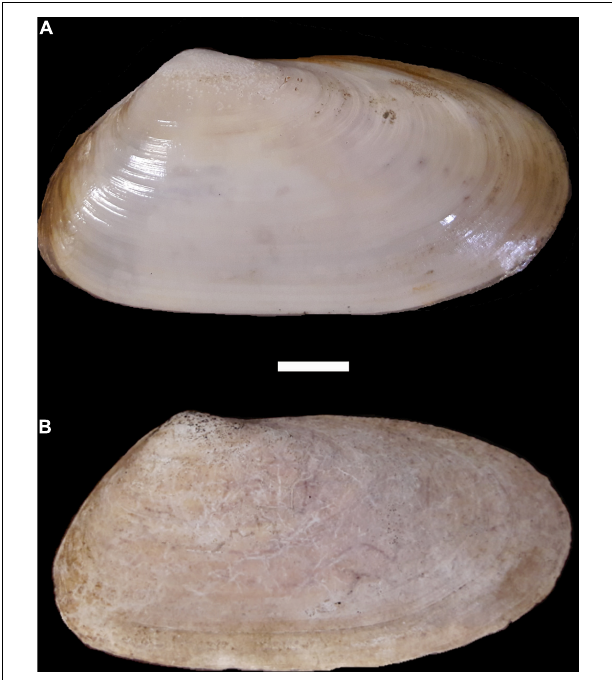
FIGURE 2 | Right Amarilladesma mactroides valves from (A) Tramandaí-Palmares do Sul transect and (B) Sambaqui Ibicuí . Scale: 1 cm.